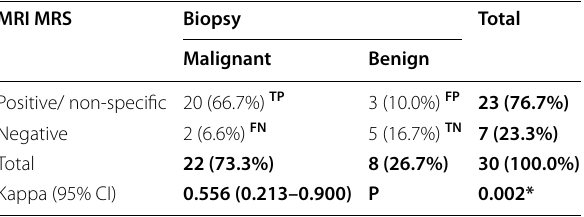
Table 8 Agreement between biopsy (reference) and MRI MRS findings (non-specific considered positive)